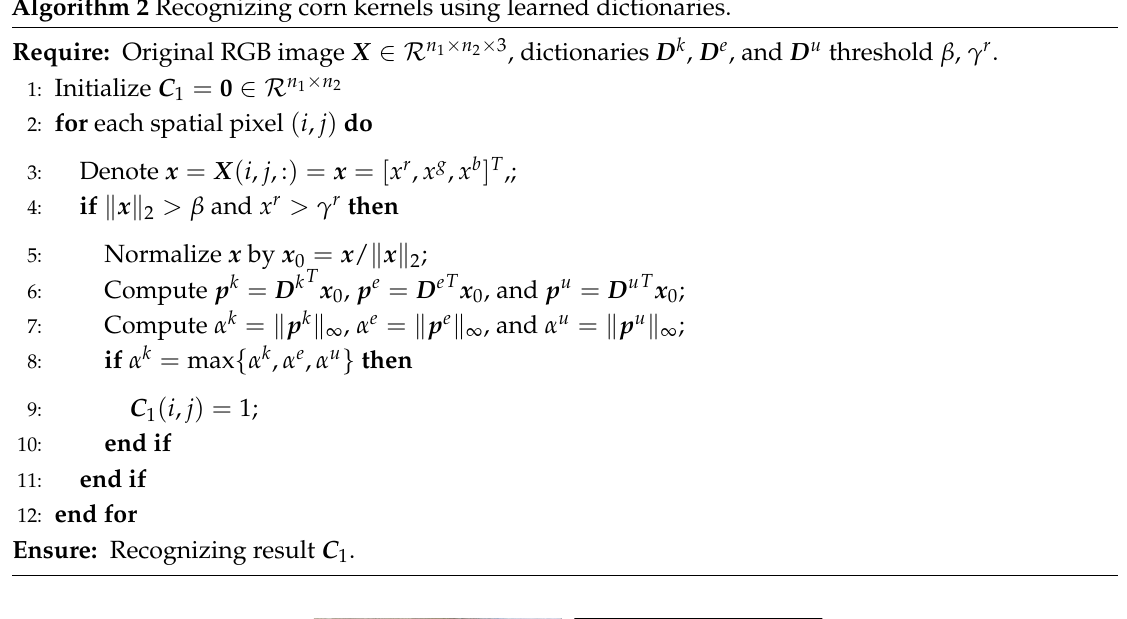
Algorithm 2 Recognizing corn kernels using learned dictionaries.